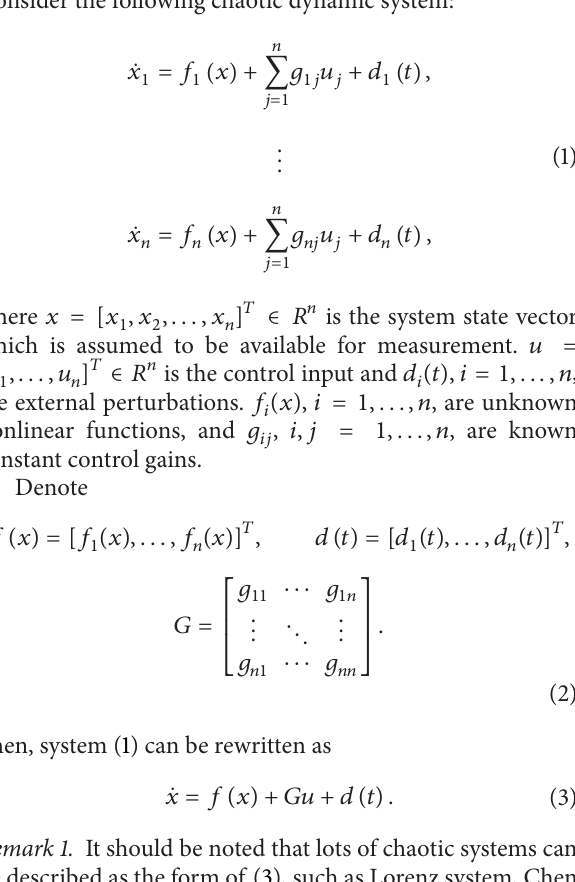
figuration of a fuzzy logic system consists of a